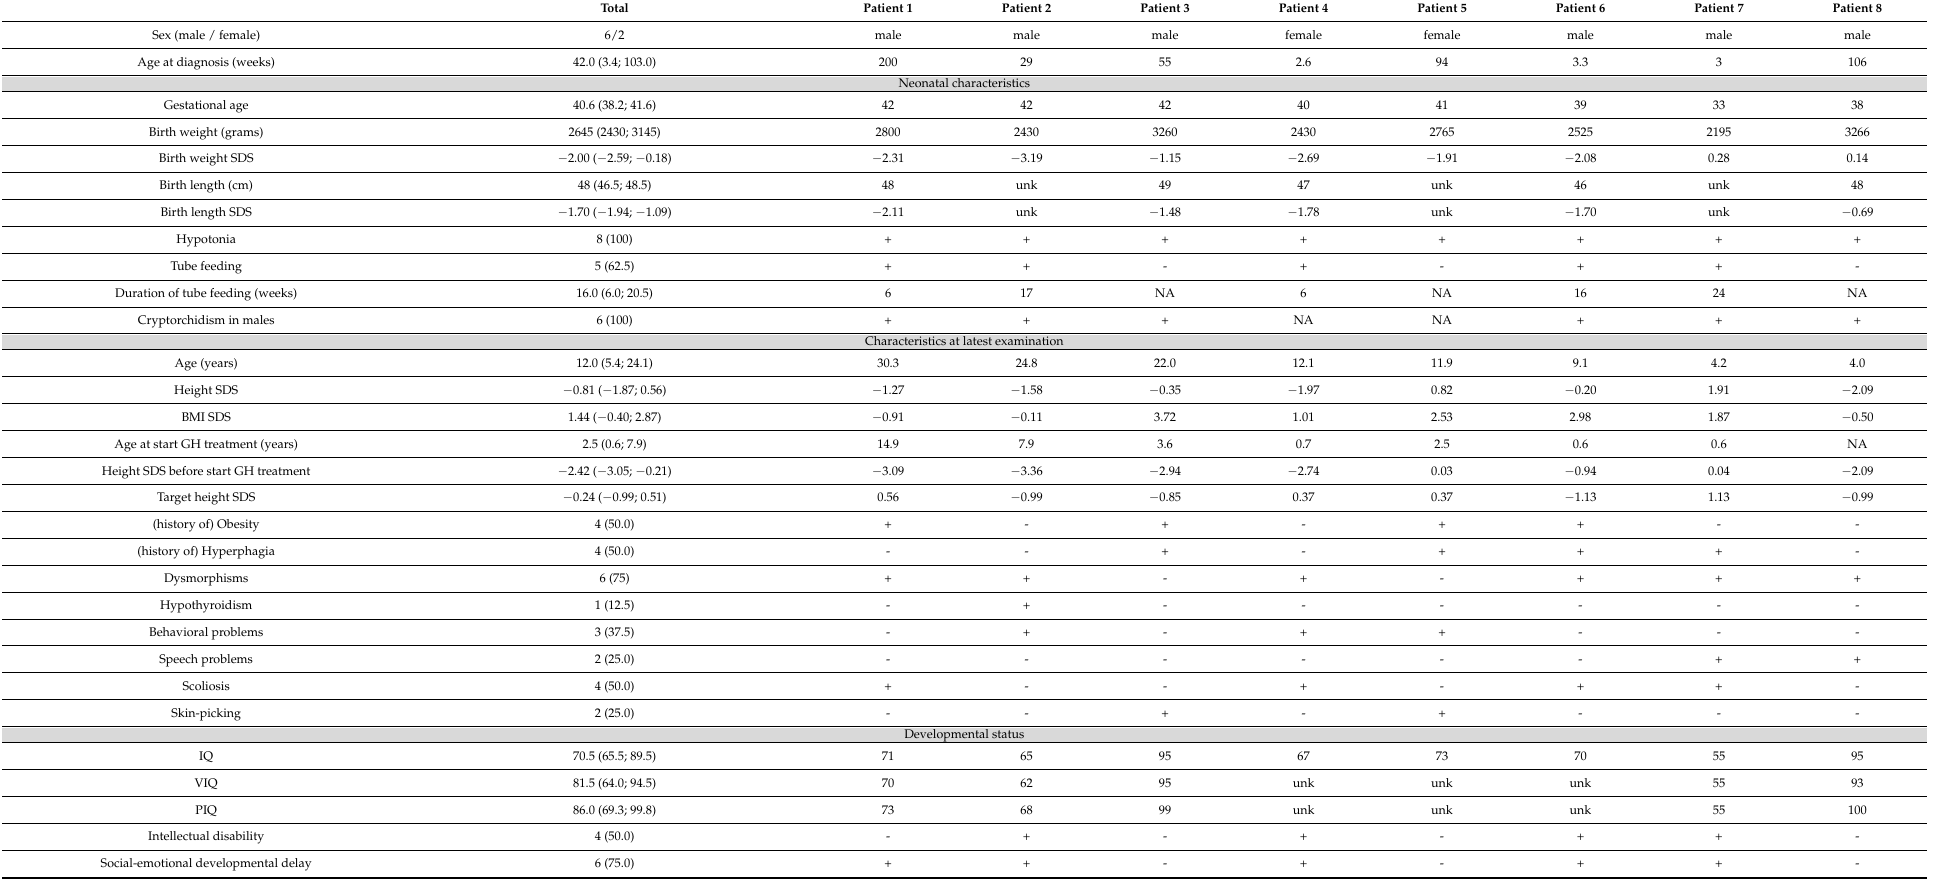
Data are expressed as median (IQR) or n (%); PWS = Prader-Willi Syndrome; SDS = Standard Deviation Score; unk = unknown; NA = not applicable; BMI = body mass index; GH = growth hormone; IQ = intelligence quotient; PIQ = performance IQ; VIQ = verbal